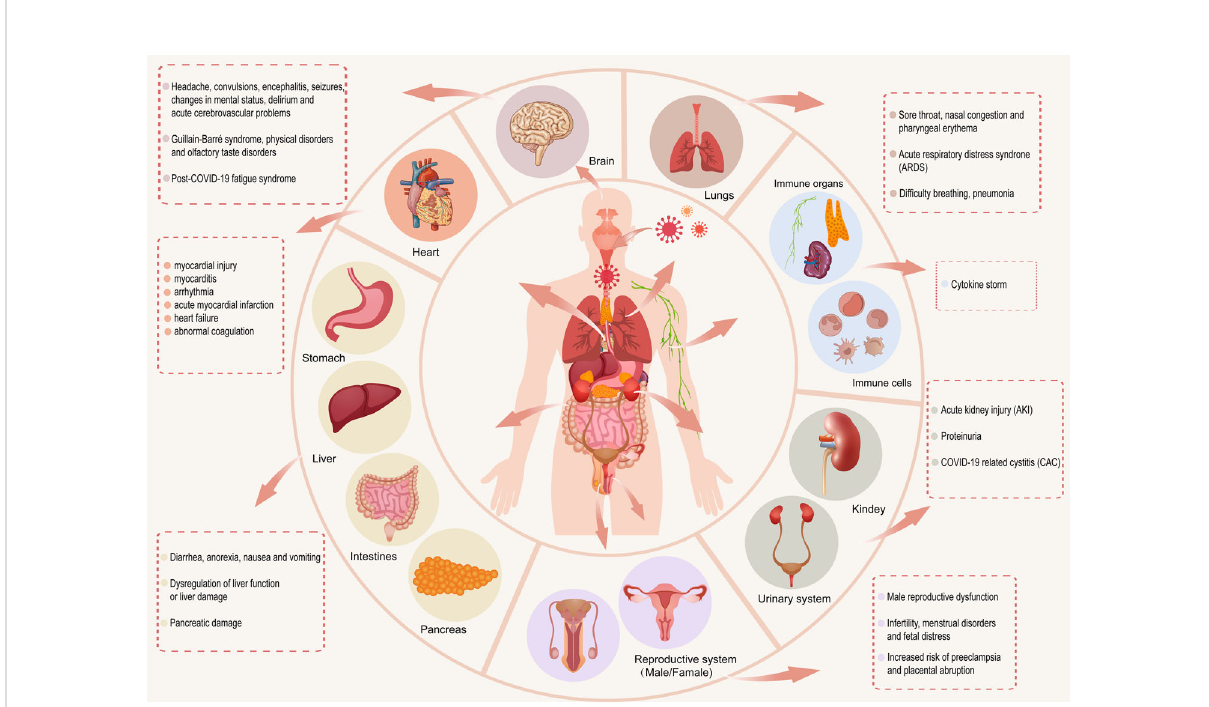
FIGURE 1 After SARS-CoV-2 enters the human body, it has different effects on the respiratory, immune, digestive, circulatory, urinary, reproductive and nervous systems of the human